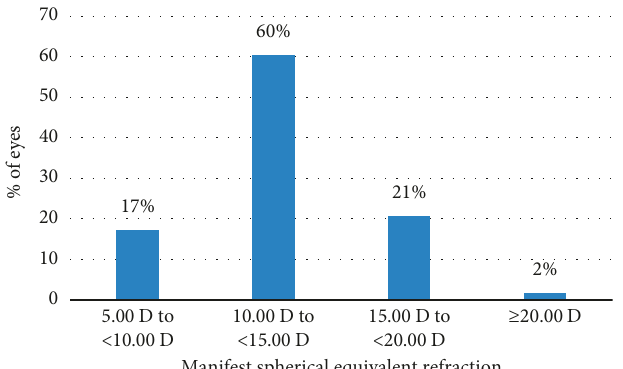
Figure 1: Distribution of manifest spherical equivalent for the patients preoperatively.